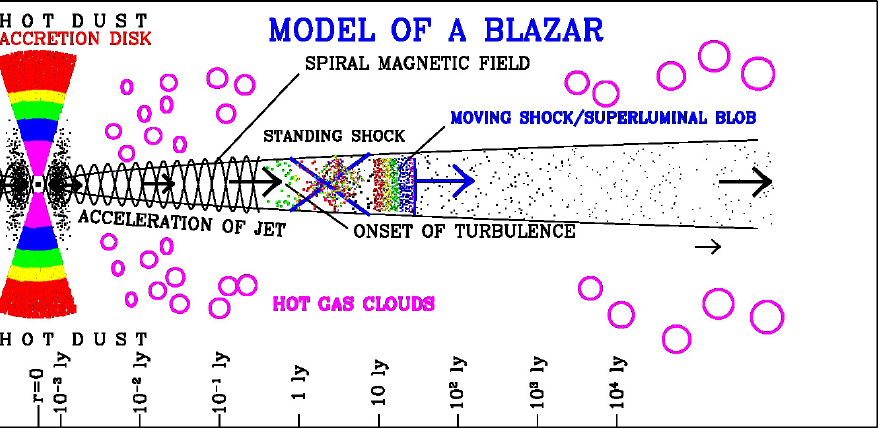
Figure 3. Blazar model proposed by Marscher. High-energy emission may arise from the acceleration and collimation zone, from a standing shock, moving shock, turbulent region or all of these. The horizontal scale is logaritmic. Copyright 2018 by A.